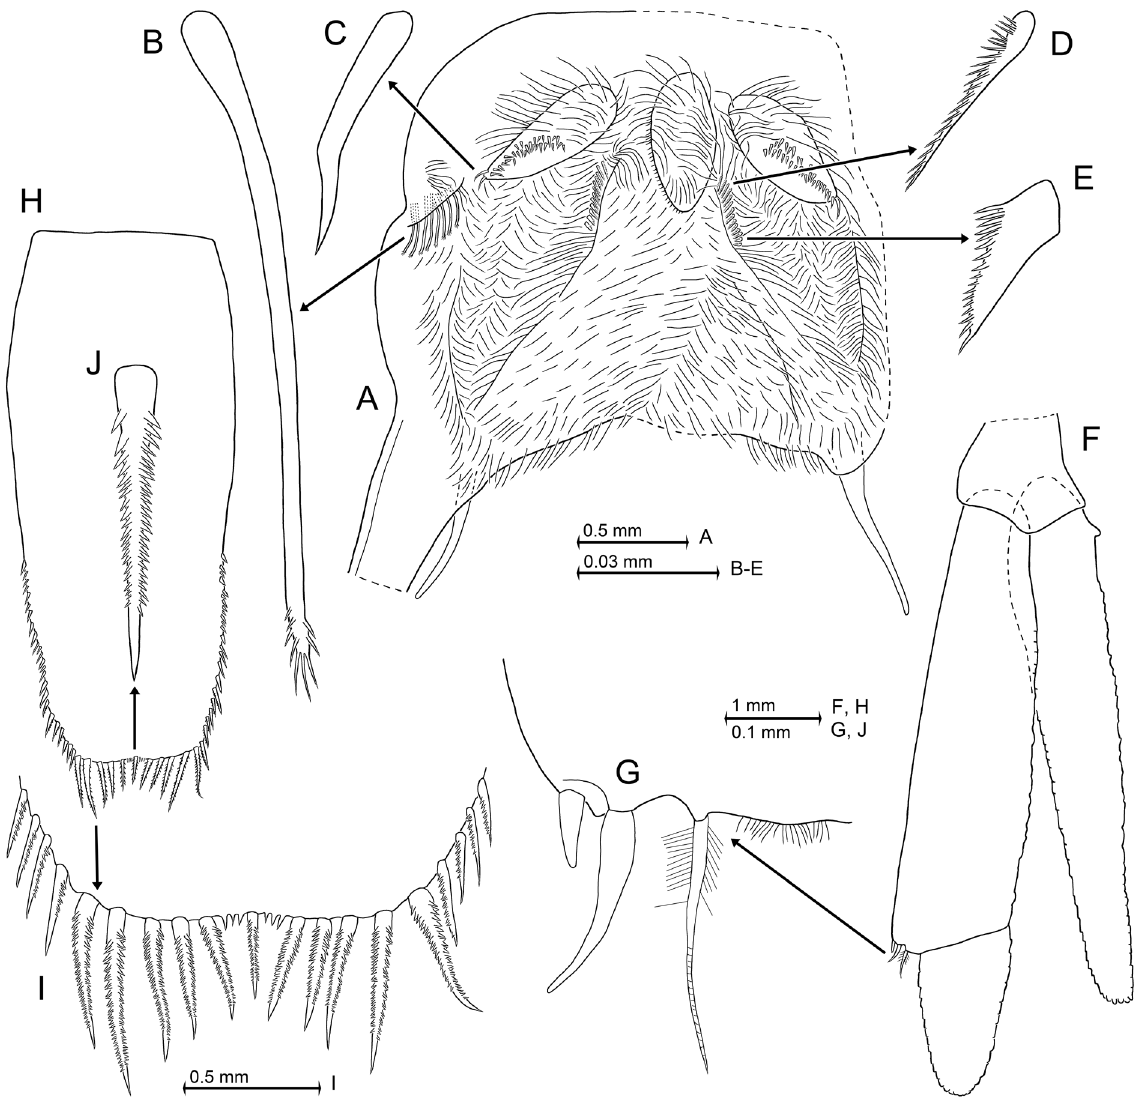
Fig. 4. Petalophthalmus cristatus sp. nov., holotype, adult female with body length 28.3 mm (ZMH 58247). A . Foregut dorsally opened, laterally unfolded and expanded on slide, distorted. B–E . Details of A, showing spines of gastric mill. F . Uropods. G . Detail of F, showing disto-lateral corner of basal segment of exopod. H . Telson. I–J . Details of H, showing terminal margin and medio- terminal spine,